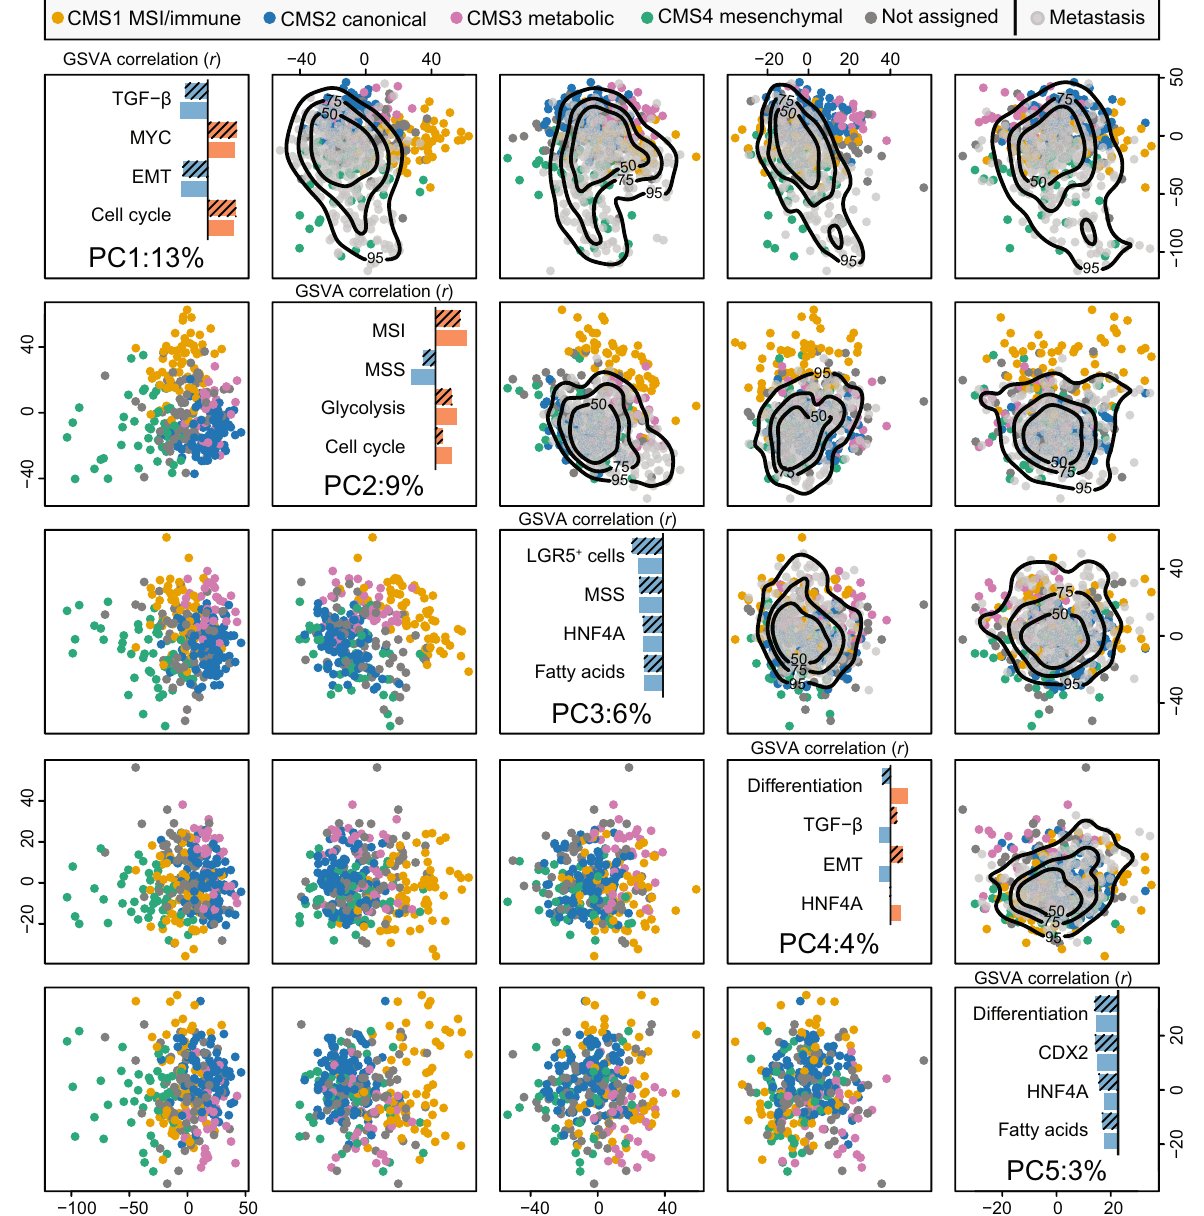
Fig. 1 Liver metastases show reduced variation along the principal components that separate CMS1 and CMS3 primary tumors from CMS2 and CMS4. The lower triangle of the scatterplot matrix depicts the fi rst fi ve principal components (PCs) for primary CRCs, with samples colored according to CMS (dark gray = not con fi dently classi fi ed). The diagonal windows show the percentage of total variance explained by each PC (bottom) and the Pearson correlations ( r ) between the indicated PC and single-sample gene set scores (GSVA) for the top-4 correlated gene sets among primary tumors (hatched bars; blue and red represent negative and positive correlations, respectively). Correlations among liver metastases are shown for comparison (non-hatched bars). The upper triangle represents the transpose of the lower triangle with the metastatic samples (light gray) superimposed by projections onto the same PCs. The black contour lines represent the 50%, 75%, and 95% two-dimensional density estimates. The presented data are from the in-house series, and results from the same analysis of the external validation data set are included in Supplementary Fig.